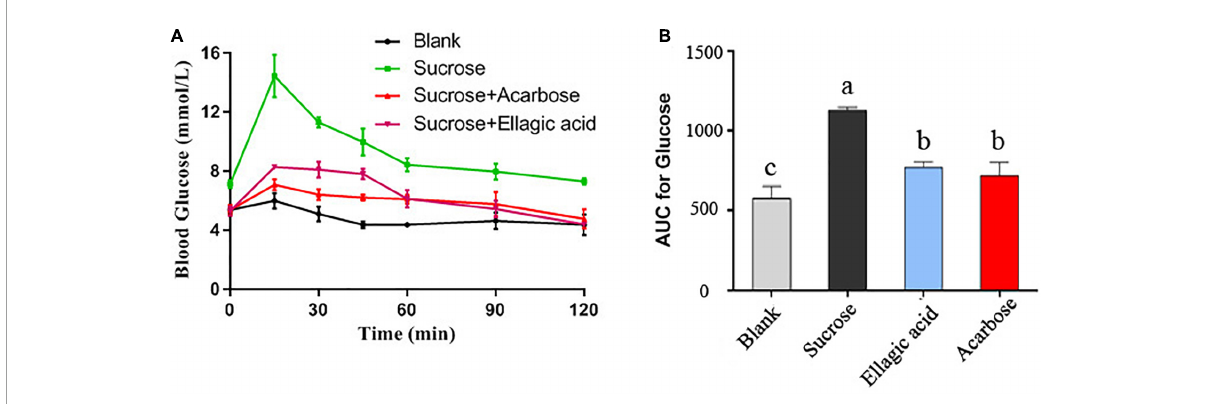
FIGURE7 The effect of EA and acarbose on the blood glucose after intragastric administration of sucrose (A) and the area under curve (AUC) of blood glucose were calculated (B) . Different letters mean p < 0.05.